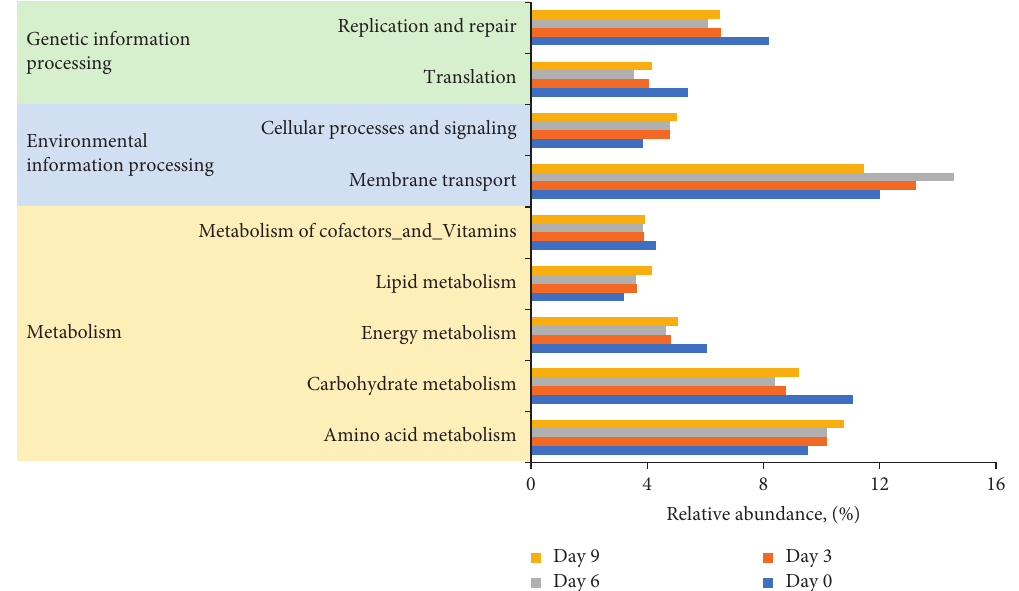
Figure 5: Presumptive functions of spoilage bacterial KEGG categories (level 2) during rainbow trout fillet storage.